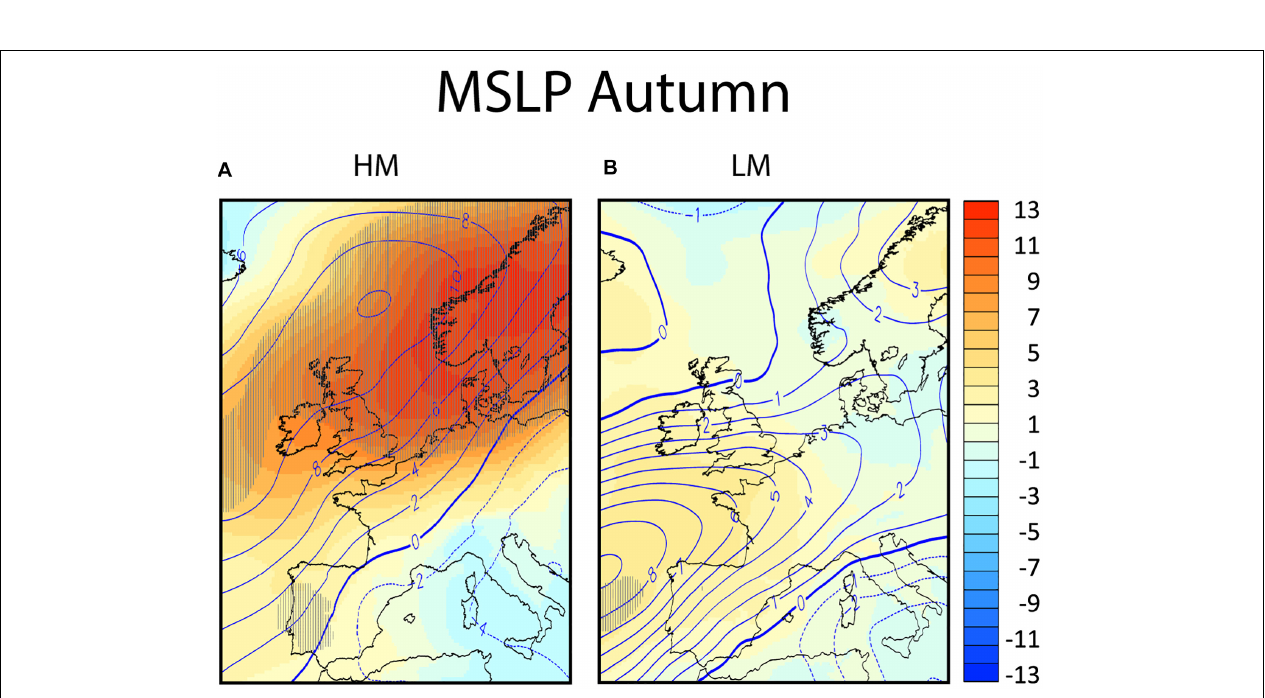
FIGURE 5 | The composites of the anomalies from climatology in autumn for the mean sea level pressure (in hPa, in colors) and for the 500 hPa geopotential height (in decameters, in contours) in panel (A) for nights of high migration intensity (HM) and in panel (B) for nights of low migration intensity (LM). Areas exceeding the 95% confidence level are